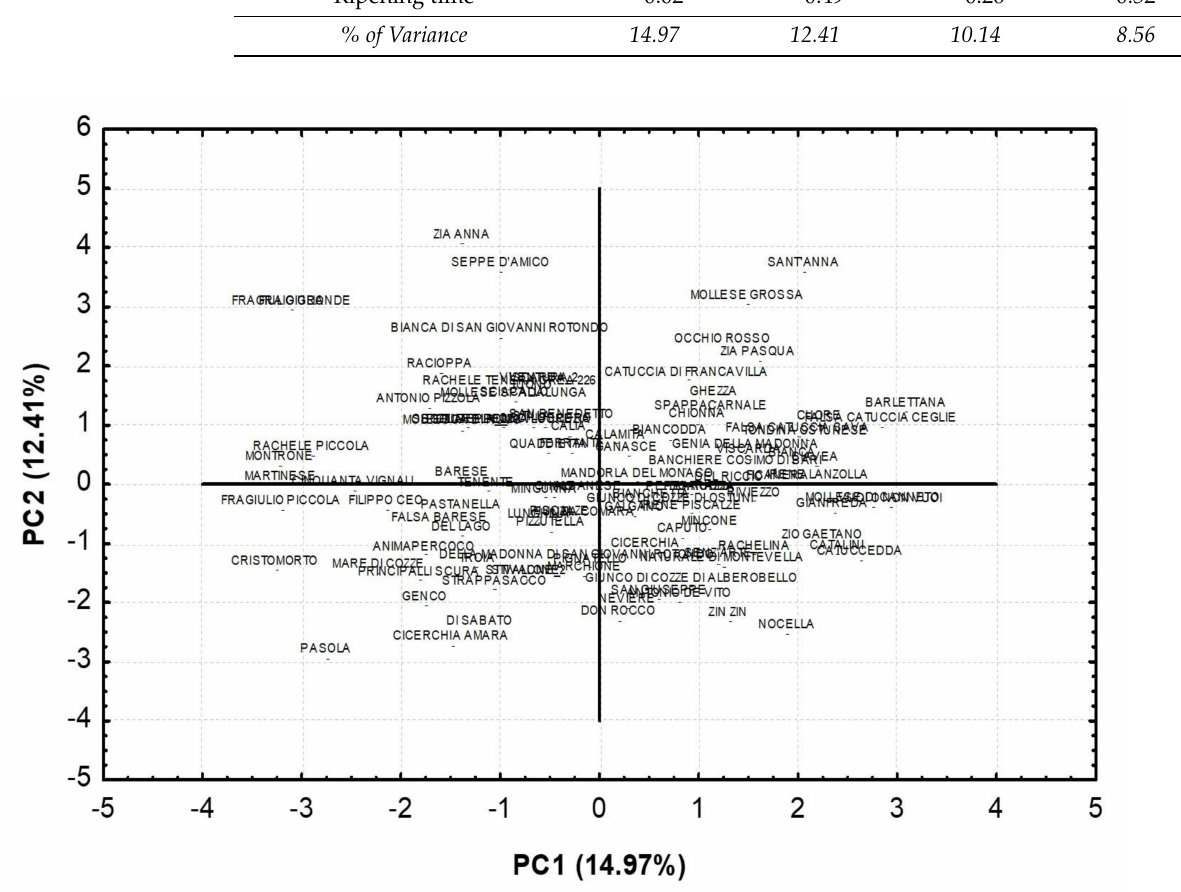
Figure 6. Factor scores of the first two principal components (PCs) for almond genotypes. The neighbor-joining clustering method utilizing all the morphological and pheno- logical data again subdivided the Apulian almond population into three main clades with comparable dimensions (Figure 7). Indeed, 39 cultivars belonged to cluster M-1, 37 were included in cluster M-2, and 33 were included in cluster M-3, the least abundant. Moreover, within each cluster it was possible to identify at least two subgroups. The subclusters